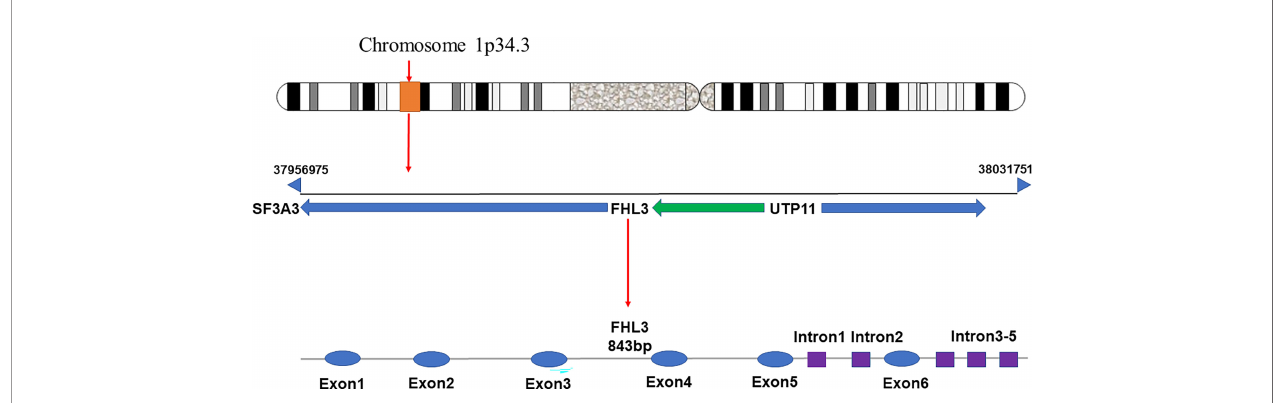
FIGURE 1 | The gene encoding FHL3 is located on chromosome 1p34.3, at a locus between SF3A3 and UTP11. The initiation site is at base-pair 37956975 and the termination site is at base-pair 38031751. The gene has an overall length of 843 bp, with 5 introns and 6